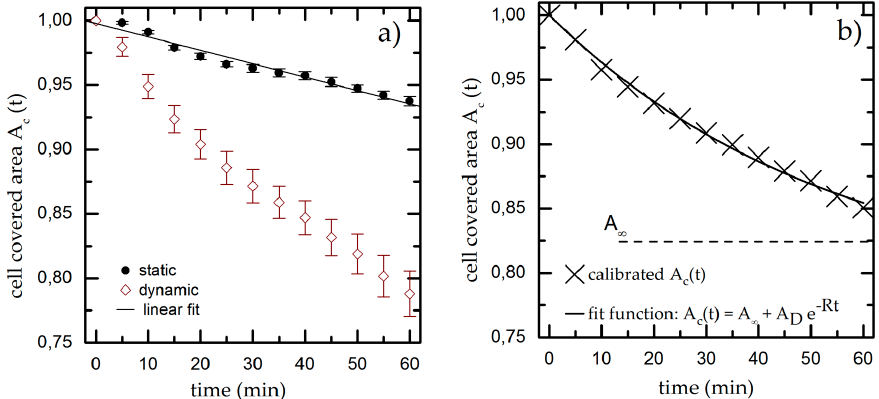
Figure 3. ( a ) Cell covered area over time under static and dynamic conditions for T = 37 °C, pH = 7.4 and R q = 3.76 µm. We fit a linear function to the static results (black line) and use it as calibration baseline to decouple the shear-induced detachment from the effects of gravity and bleaching. The data points and error bars show the mean and standard deviation respectively from n ≥ 5 measurements; ( b ) Dynamic measurement from ( a ) normalized to the linear fit extracted from the static